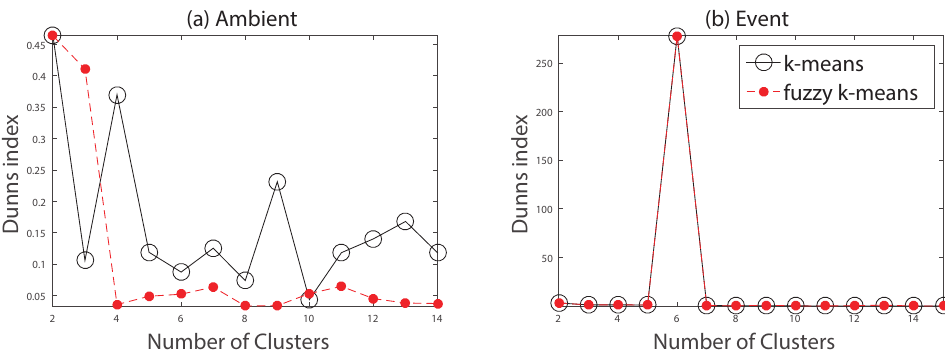
Figure 6. MSPCA-based data compression. ( a ) Original detail matrix D 1 , ( b ) saved principle components (PCs), ( c ) saved scores, and ( d ) reconstructed detail matrix ˆ D 1 using saved PCs and scores.